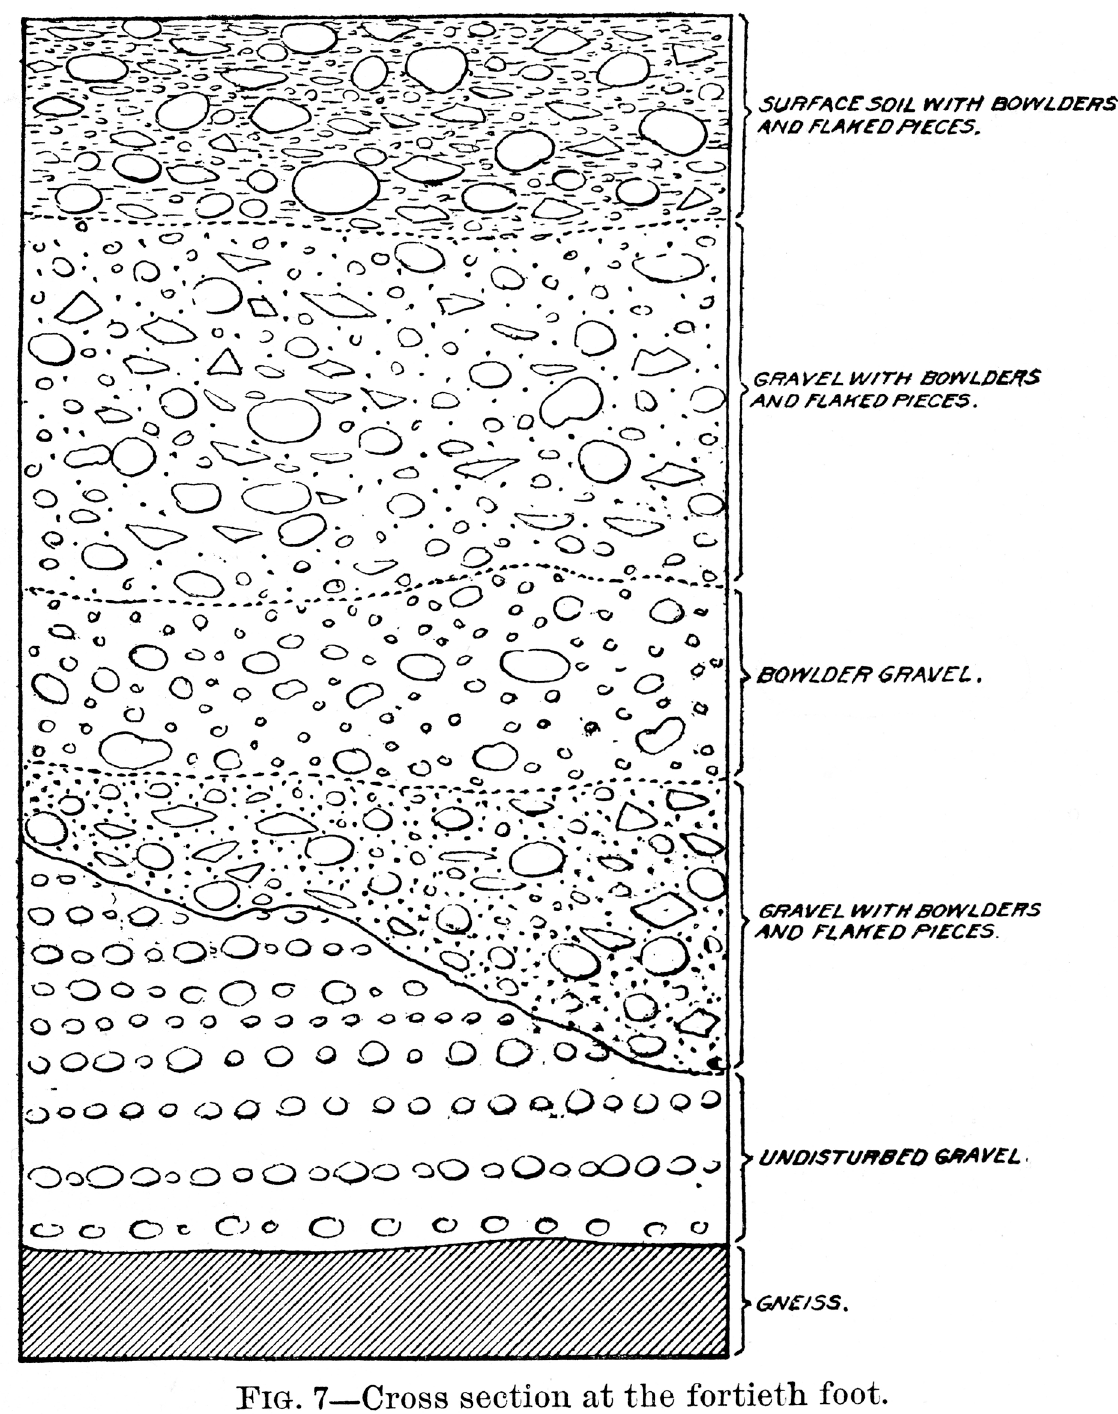
Figure 7. Deposits at Piney Branch showing four strata overlying the undisturbed gravel at the base. After Holmes 1897: fig. 7. [Original caption: Cross section at the fortieth foot. (Strata are labelled, from bottom to top) Gneiss. Undisturbed gravel. Gravel with bowlders and flaked pieces. Bowlder gravel. Gravel with bowlders and flaked pieces. Surface soil with bowlders and flaked